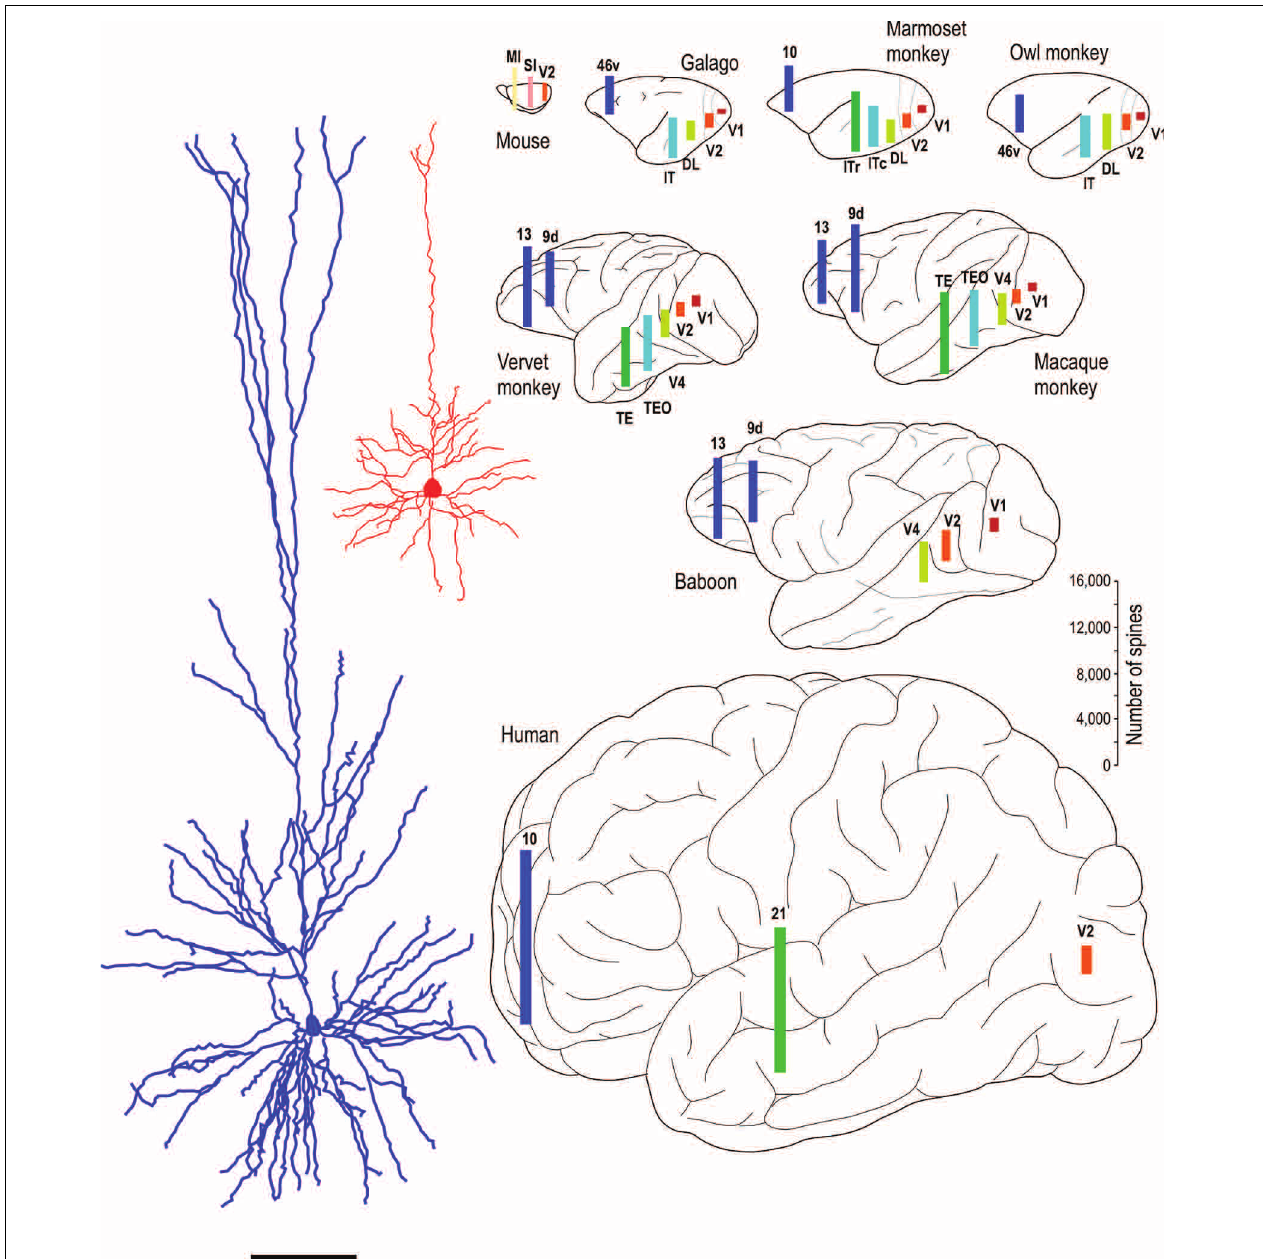
FIGURE 13 | Specialization in pyramidal cell structure in the adult brain. Schematic illustrating regional and species differences in pyramidal cell structure. At left are illustrated two individual layer III cells sampled from the primary visual area (V1) and the inferotemporal cortical area TEpd of the adult macaque monkey. Note the difference in thickness of layer III between the two cortical areas, the tangential extent of both the basal and apical dendritic trees. Illustrated at right are the estimates of the total number of spines in the basal dendritic trees of layer III pyramidal cells in visual areas V1, V2, V4 (DL), TEO (ITc), TE (ITr), and prefrontal cortex (areas 9d, 10, 13, and 46v of Preuss and Goldman-Rakic, 1991). Prefrontal cortex refers as originally defined by Brodmann (1913) as granular cortex anterior to the central sulcus (see Elston and Garey, 2004, for a translation). Bars are color coded for homology, that is, homologous/analagous cortical areas are illustrated by